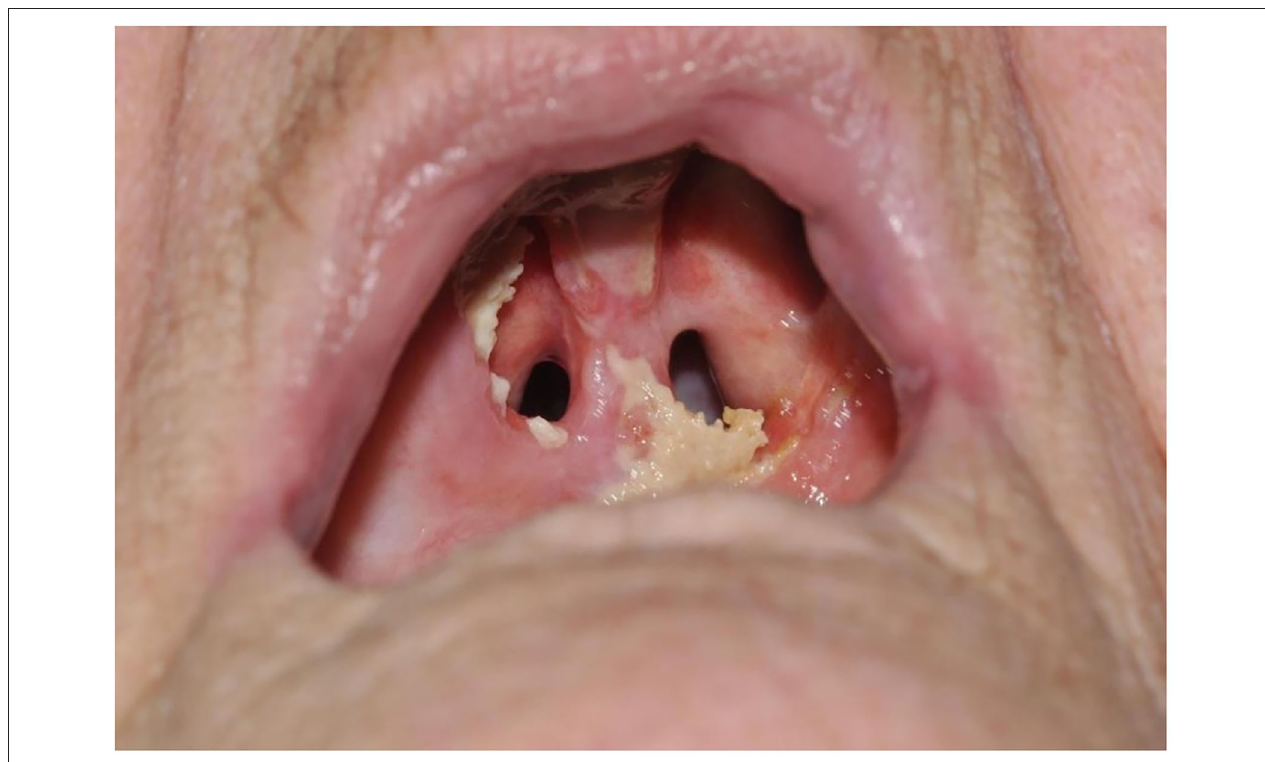
FIGURE 5 | Photodynamic therapy patient with oronasal fistula, 3 months after PDT illumination of the hard